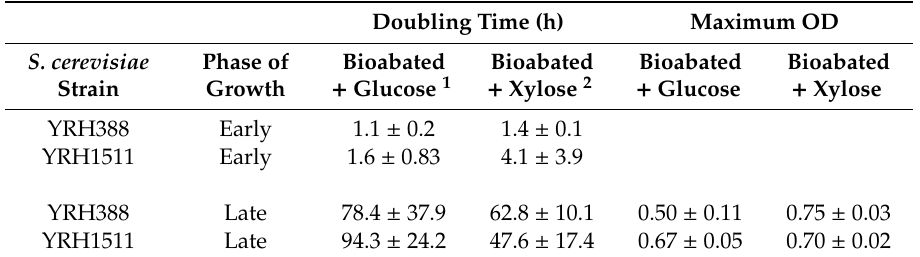
Figure 5. Growth of YRH388 and PPP mutant YRH1511 in recycled corn stover dilute-acid hydrolysate supplemented with glucose (top) or xylose (bottom). Due to carryover of unconsumed xylose in recycled hydrolysate, the hydrolysate shown in the top panels contained 0.20% ( w / v ) xylose along with 0.14% ( w / v ) added glucose. The bottom panels had no residual glucose and 0.52% added xylose. Each panel shows four replicates (shown as individual lines of various colors) for the indicated strain and hydrolysate in microwell growth assays. Table 5. Growth of S. cerevisiae YRH 388 and YRH1511 in recycled corn stover hydrolysate.